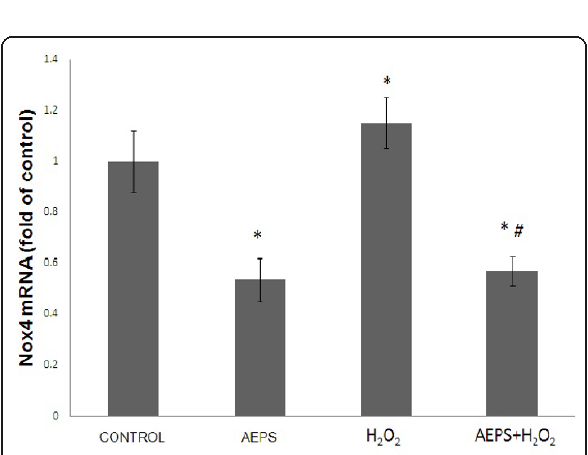
Figure 4 Nox4 mRNA expression in HUVECs . Figure 4 represents the bar chart showing Nox4 mRNA expression in control, AEPS, H 2 O 2 and AEPS + H 2 O 2 groups. HUVECs treated with AEPS had lower Nox4 mRNA expression while H 2 O 2 caused a higher Nox4 mRNA expression. Data are denoted as mean ± SEM of n = 6. (*) p < 0.05 vs. control; (#) p < 0.05 vs. H 2 O 2